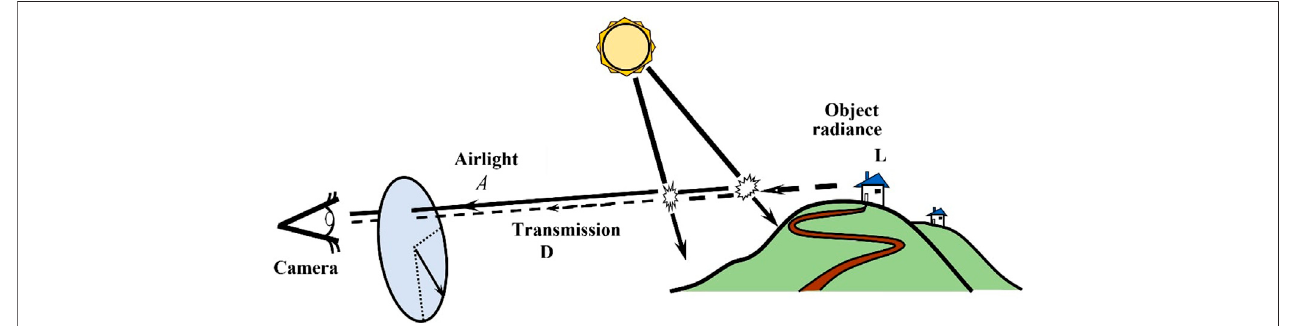
FIGURE 3 | Polarization-based atmospheric scattering model (reprint from OSA: Applied Optics [32], copyright 2003).